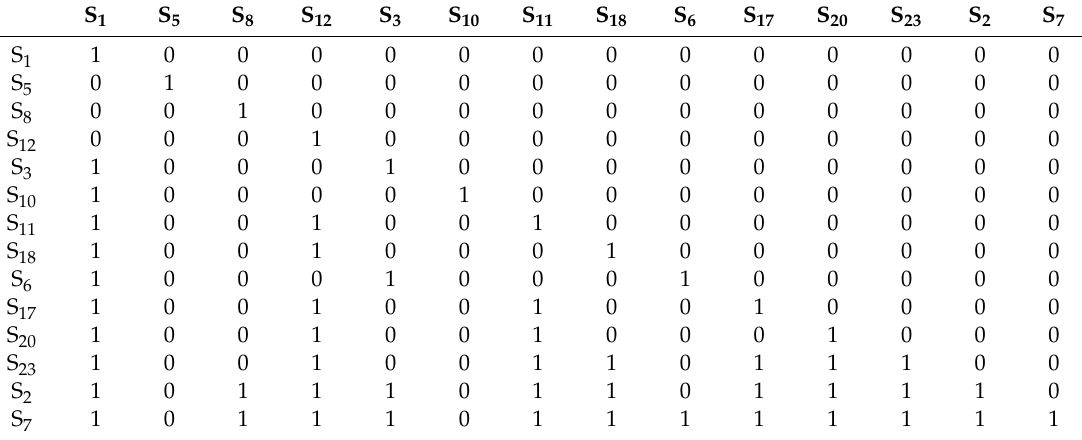
Table 6. The ordered reduced accessibility matrix of super-gentrification dynamic